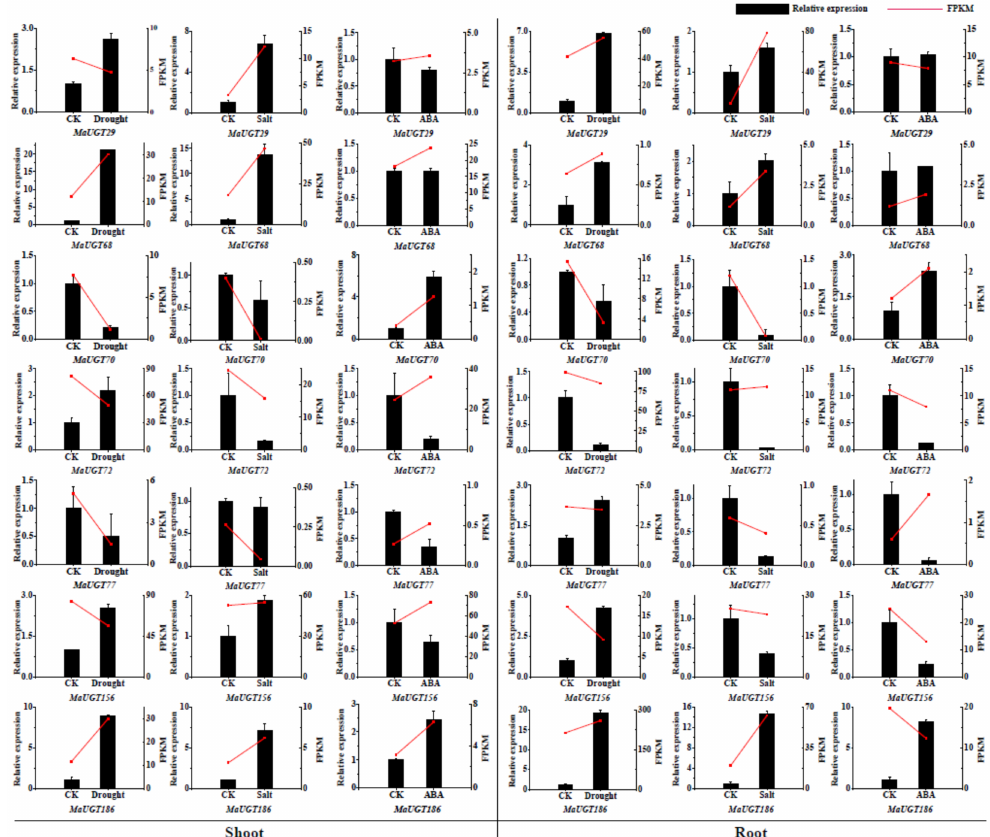
Figure 5. Confirmation of the expression patterns of the MaUGT genes under abiotic and ABA stress in shoots and roots using qRT–PCR. The values shown are the means ± standard deviation of three replicates. Matubulin was used as the reference gene. Red lines indicate the expression values (FPKM) from RNA-seq data. CK represents